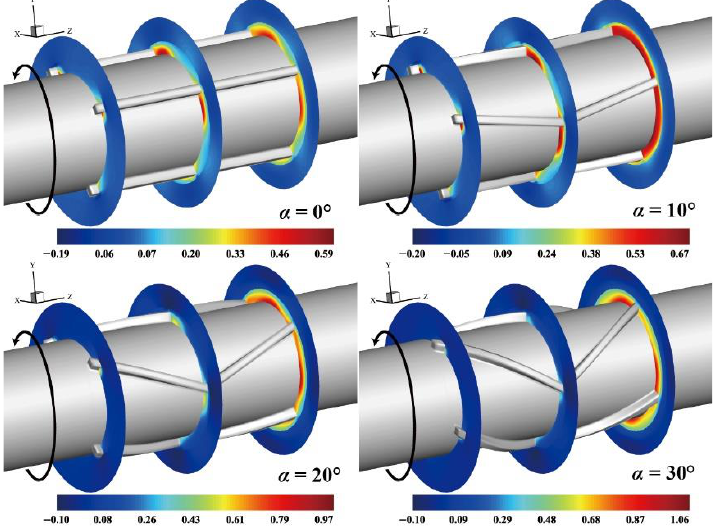
Figure 11. Fluid circumferential velocity distribution at different cross sections of the blade under different helix angles.